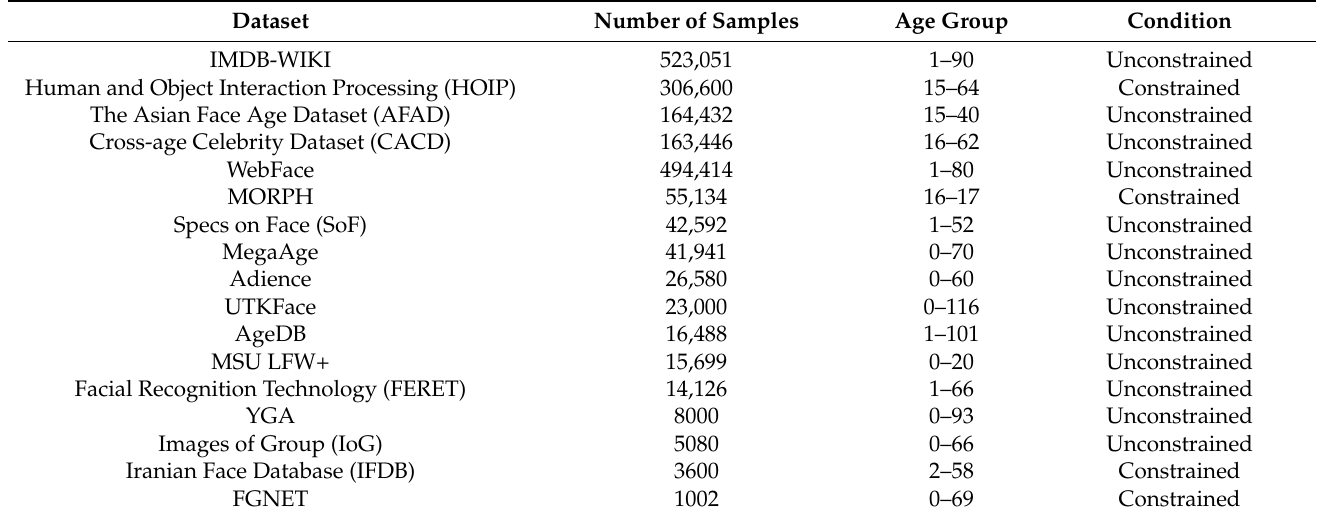
Table 1. Datasets available for building and training age estimation